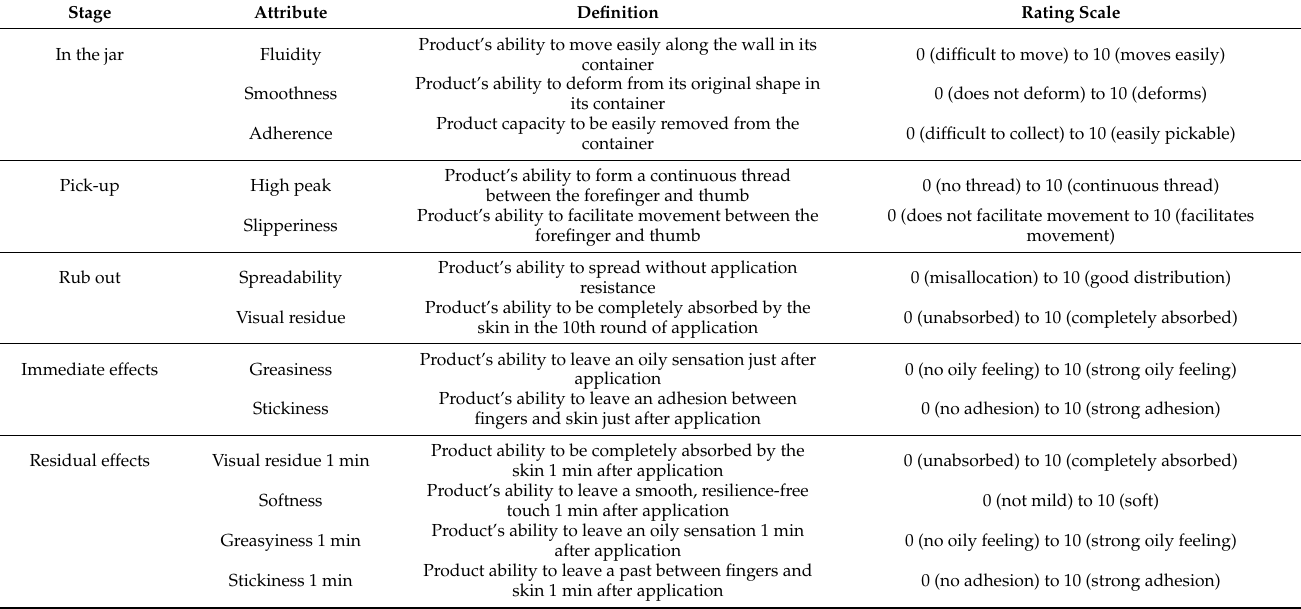
Table 1. List of selected attributes, their definition, and extreme rating